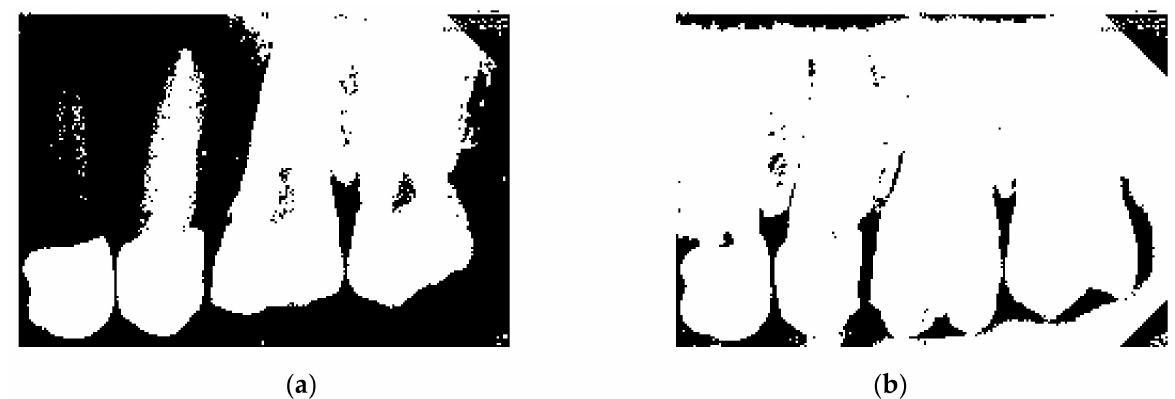
Figure 2. The result of the images. ( a ) image binarization, ( b ) adaptive threshold processing. This proposal summarizes the range of the sum of pixels where the appropriate threshold is located by calculating the sum of the pixels of each grayscale image. However, the calculation cannot be performed immediately after converting the image because not every interdental gap is vertical. Therefore, rotating the image is a necessary step before calculation. Additionally, image rotation is performed by rotating the image 12 degrees clockwise and 12 degrees counterclockwise [24]. After rotating the image, the 24 positions and value of the minimum pixel sum for each angle can be computed. The 24 values are then compared with the smallest value being the most suitable position and angle for segmentation. Since the number of PA image teeth in the database is at most four teeth, a maximum of four cutting lines are required. This means that the above steps need to be repeated four times. However, the number of teeth in the PA images is not always four and some images have only three. In this case, the redundant dividing line needs to be removed. Therefore, this study designed two methods to address this problem. The first method is based on the relative position of the fourth cutting line to the other cutting lines. Assuming that the distance between the fourth cutting line and the other cutting lines is less than the width of one tooth, the fourth cutting line should be removed. The second method is that if the value of the fourth row is greater than the average, it means that the fourth row is very likely not on the tooth. Thus, the fourth row can be removed by this feature. Figure 3a shows the result of finding all the dividing lines. Figure 3b is the result of removing the redundant dividing lines. When the cutting line is inclined, the image segmented by the cutting line is not rectangular. However, for the subsequent training of CNN when normalized, the target in this step is a rectangular one. Therefore, this proposal adds a green vertical line to the far right and a blue vertical line to the far left of each cutting line. Moreover, it segments the first segmented image with the leftmost position of the original image and the first green vertical line as the boundary. The second segmented image is bounded by the first blue vertical line and the second green vertical line. The third and fourth cut images are similarly